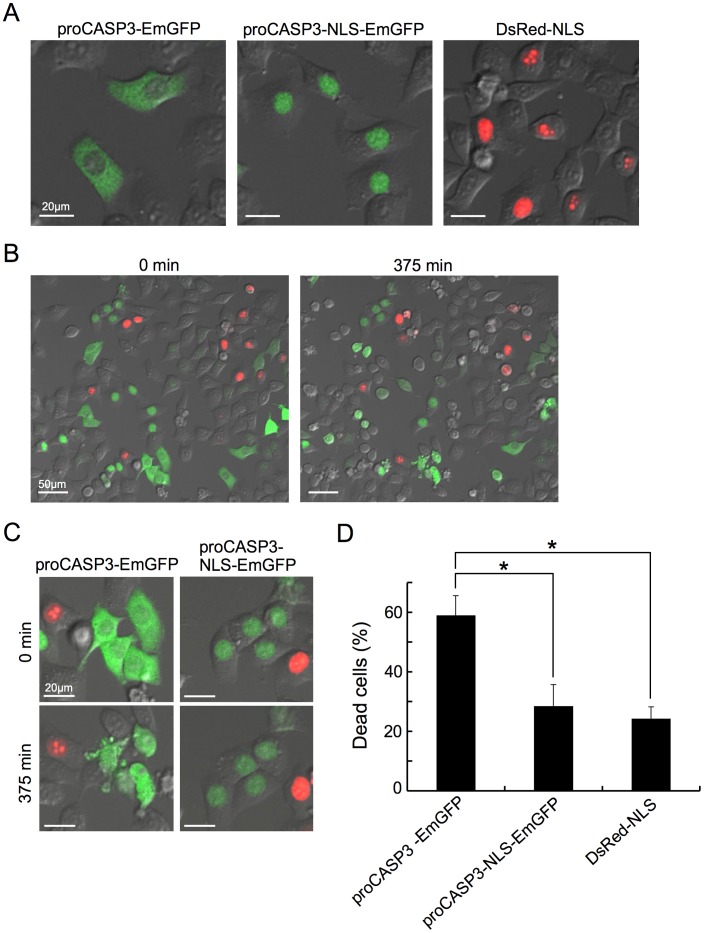
Nuclear proCASP3 did not promote apoptosis.(A–D) HeLa cells were separately transfected with the plasmid expressing EmGFP-tagged wild type proCASP3 (proCASP3-EmGFP), nuclear localization signal (NLS) containing proCASP3-EmGFP (proCASP3-NLS-EmGFP), or DsRed-NLS fusion protein (DsRed-NLS). After 24 hr, transfected cells were trypsinized and plated together in one glass bottom dish. After a further 24 hr, apoptosis was induced by the addition of anti-Fas antibody. Cells expressing the indicated fusion protein are shown (A). Behavior of the EmGFP-fusion protein positive and DsRed positive cells (same field at different times) was recorded by live imaging (B). Representative frames showing images of cells expressing the indicated fusion protein in a given field, as recorded in Figure 5B, are displayed (C). Scale bars = 20 µm (A and C), 50 µm (B). The number of apoptotic cells (based on cell morphology) was counted at 450 min after apoptosis induction by anti-Fas antibody (D). A minimum number of 30 cells were counted in a field for each type of fusion protein expressing cells. Four fields were randomly chosen for counting the number of apoptotic cells. Error bar: mean ±SD. *P<0.001.